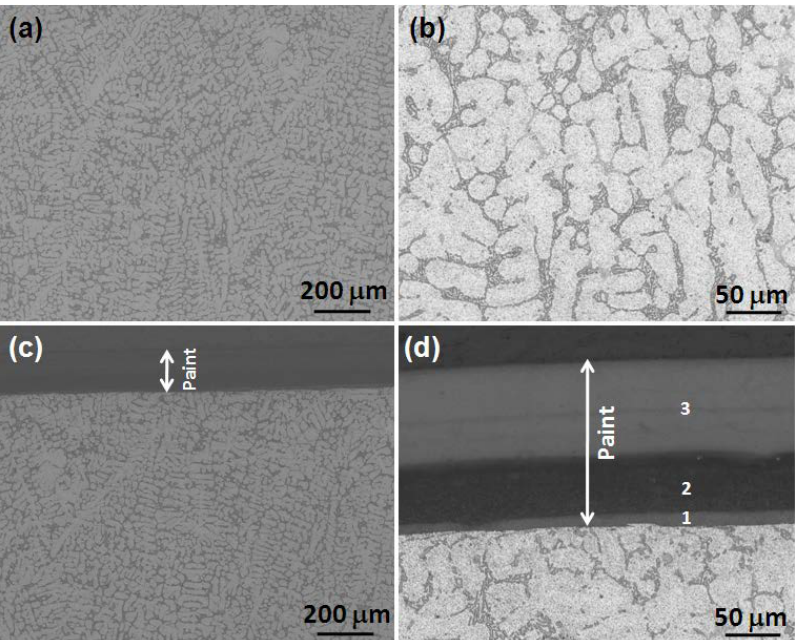
Figure 14: Optical microstructures of the base of the antenna: (a) low and (b) high magnifications; optical microstructure taken from the edge showing different layers of paint: (c) low and (d) high magnifications.